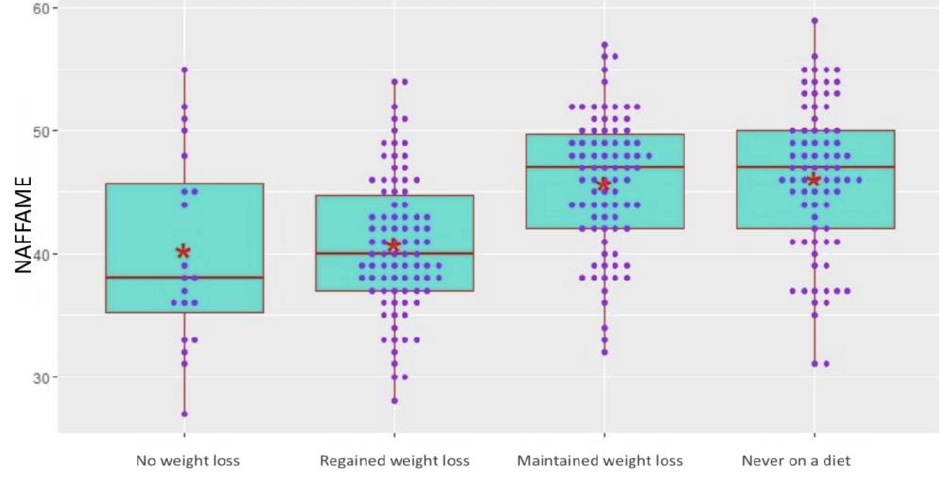
Figure 3. ANOVA test displaying the difference in 10-MDLNFF scores of various outcomes of weight-reducing diet.